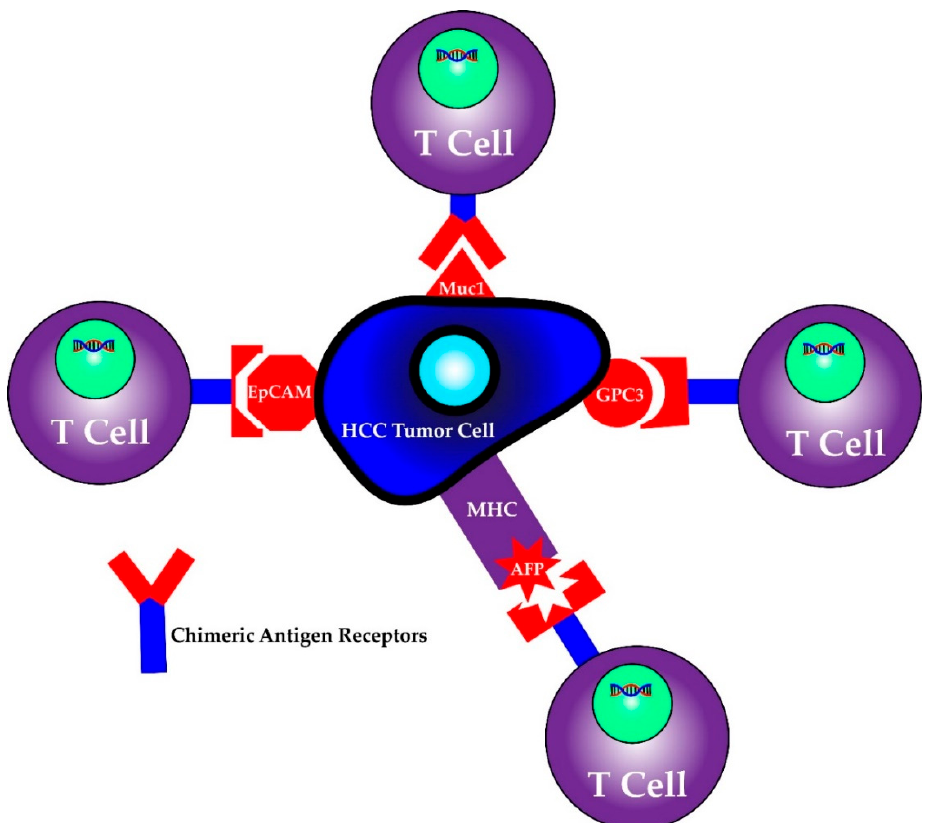
Figure 4. CAR T cells can be programmed to recognize individual antigens.